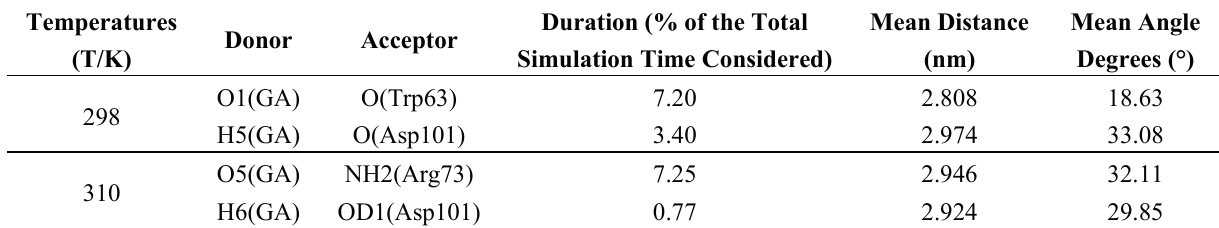
Figure 11. Interaction of GA with LYS, only residues around 21.2 Å of the ligand is displayed. ( A ) The interaction mode between GA and LYS before MD simulation; ( B ) The interaction mode between GA and LYS after 298 K MD simulation; ( C ) The interaction mode between GA and LYS after 310 K MD simulations. The ligand structure is represented using a green stick model, where the red sticks within represent oxygen. The hydrogen bond between the ligand and the protein is represented using a red dashed line. Table 3. H bonds formed between GA and